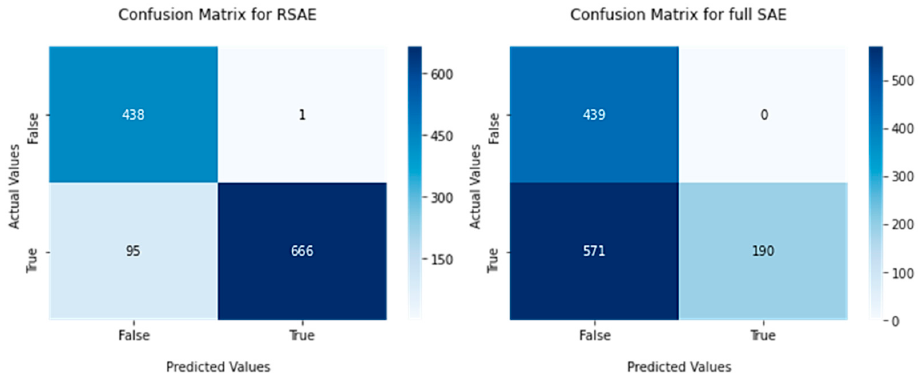
Figure 12. This plot shows the traditional SAE, along with its subsequent thresholds, with green, orange and red being 99.95, ~99.975 and 99.99 percentile error from our model.